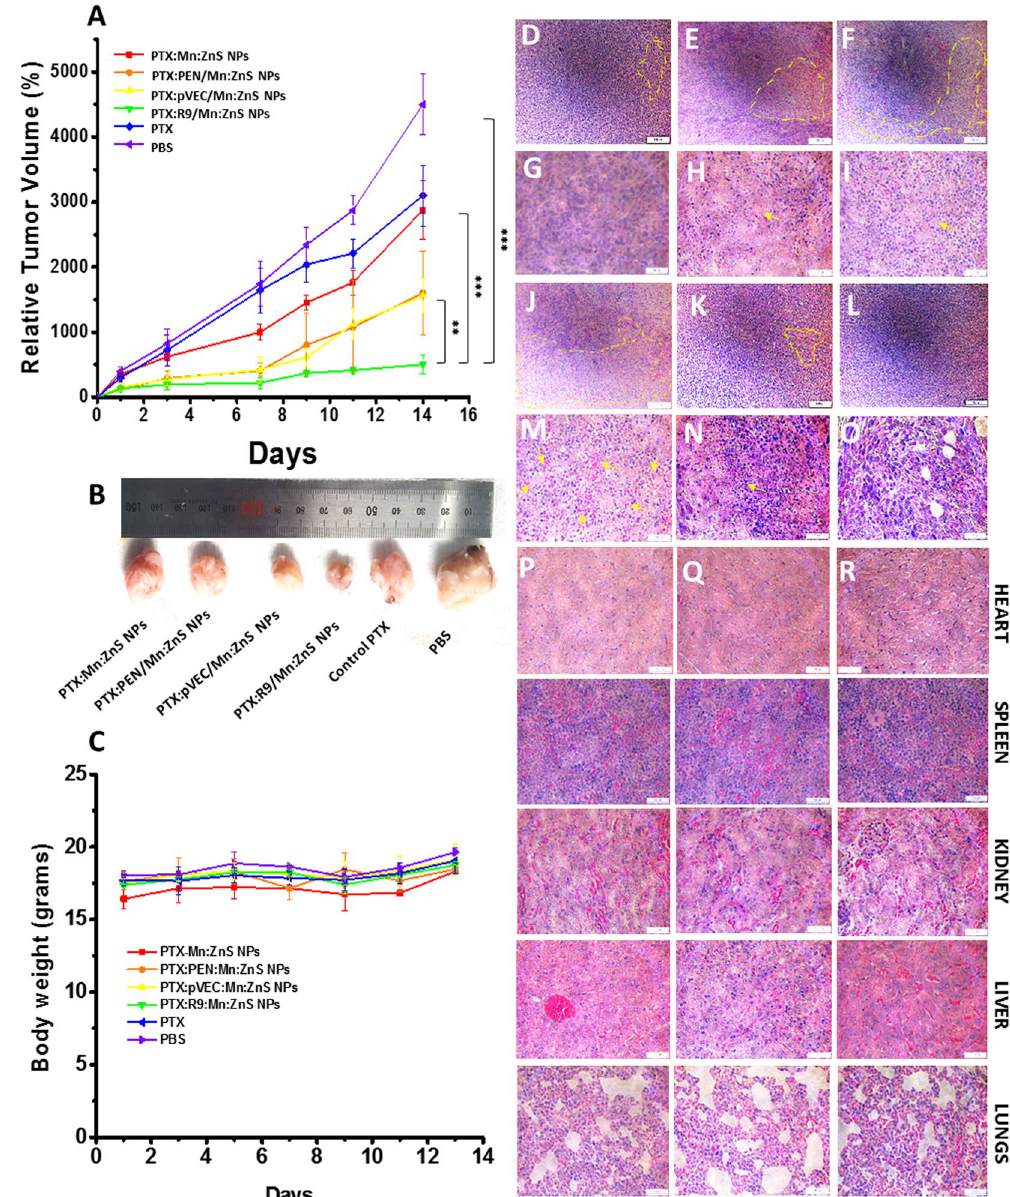
Figure 7. Therapeutic efficacy studies using breast tumor xenograft model (Balb/c mice): ( A ) tumor reduction studies after injecting the samples once per week till 14 days; ( B ) represents the tumor tissues dissected two weeks after the therapy, showing significant reduction with PTX:R9/Mn:ZnS NPs compared to the other CPP modified PTX loaded Mn:ZnS NPs. ( C ) shows no body weight loss after treatment with the respective sample for two weeks of experiments. ( D – O ) represents the ( H , E ) staining of tumors two weeks after euthanasia, showing apoptotic pathology. ( D – F , J – L ) represents the PTX:Mn:ZnS NPs, PTX:PEN:Mn:ZnS NPs, PTX: pVEC/Mn:ZnSNPs,PTX:R9/Mn:ZnS NPs; control PTX, PBS (lower magnification of 10 × ) and ( G – I , M – O ) shows their higher magnifications (40 × ) respectively; The yellow dots show the affected area and arrows represent the apoptotic nuclei. ( P – R ) are the H and E stained major organ tissues after treatment with ( P ) PTX:R9/Mn:ZnS NPs; ( Q ) control PTX, ( R ) PBS showing non-toxicity at in vivo ((n = 6, ** represents p < 0.01 and *** represents p <